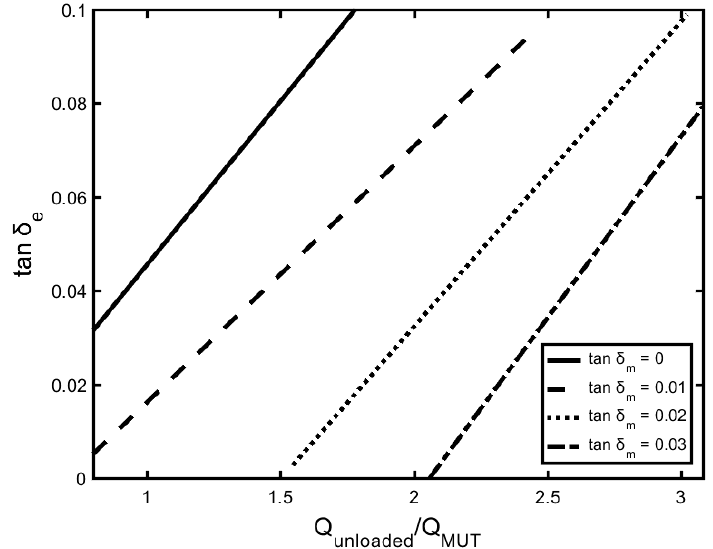
Figure 12. Results of the electric loss tangent as a function of the inverse normalized quality factor for different values of magnetic loss tangent.